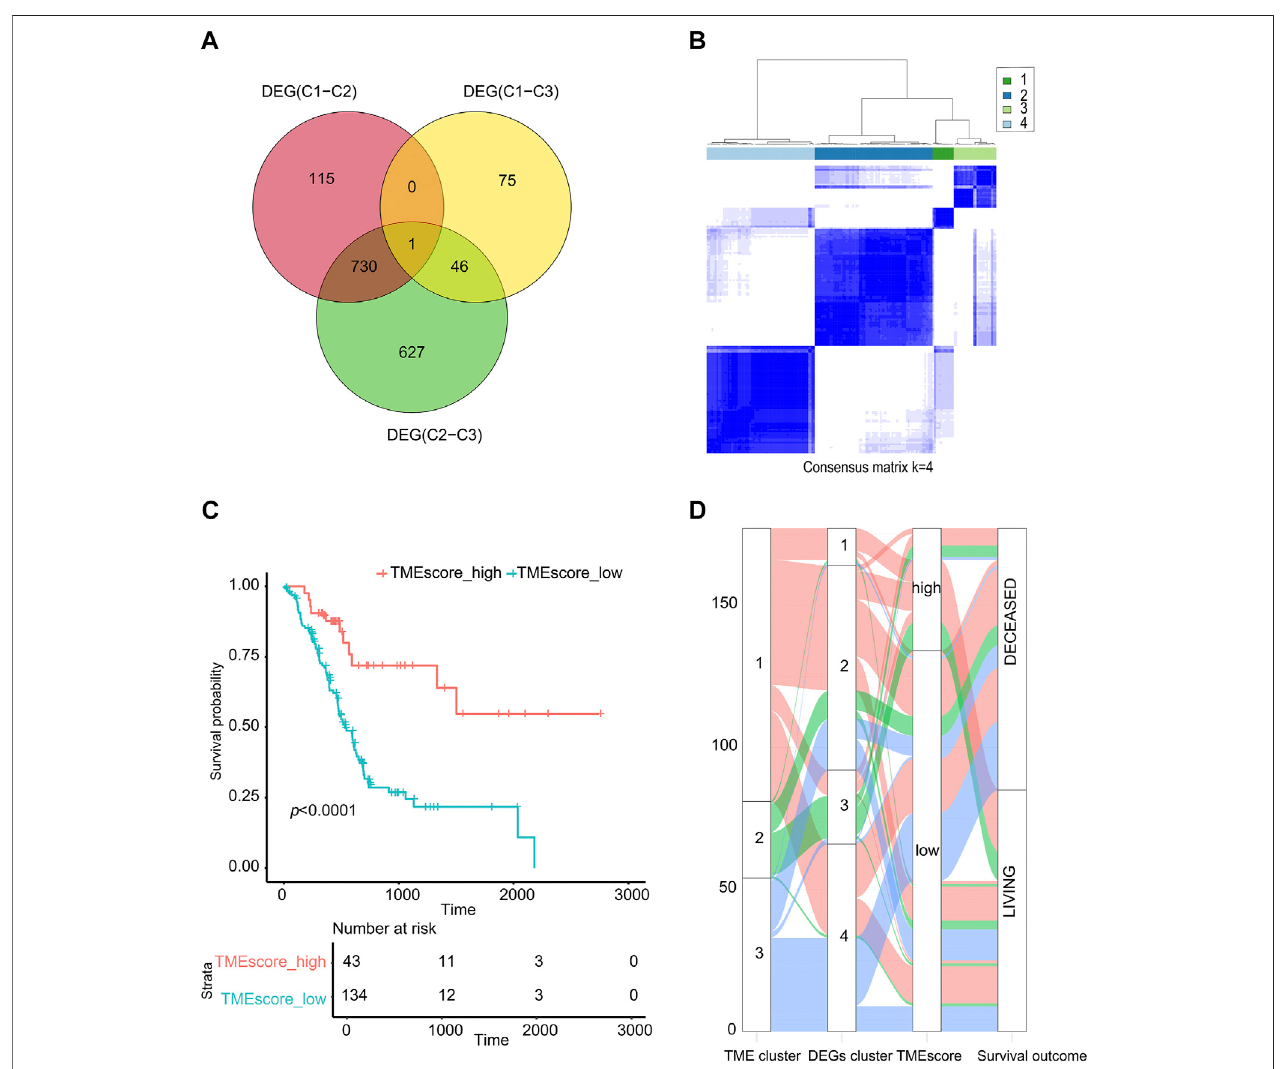
FIGURE 2 | TMEscore value calculation and survival analysis. (A) Venn analysis for DEG. (B) Cluster analysis of samples based on DEGs. (C) The sample was analyzed by TMEscore for survival. (D) The alluvial diagram of TMEcluster and the TMEscore group.